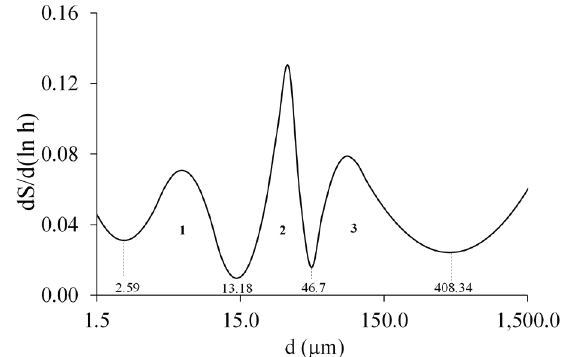
Figure 1 - Typical pore size distribution curve (PSDC) obtained through the cubic spline adjustment. The numbered peaks correspond to the matrix (1) and structural (2 and 3) porosity